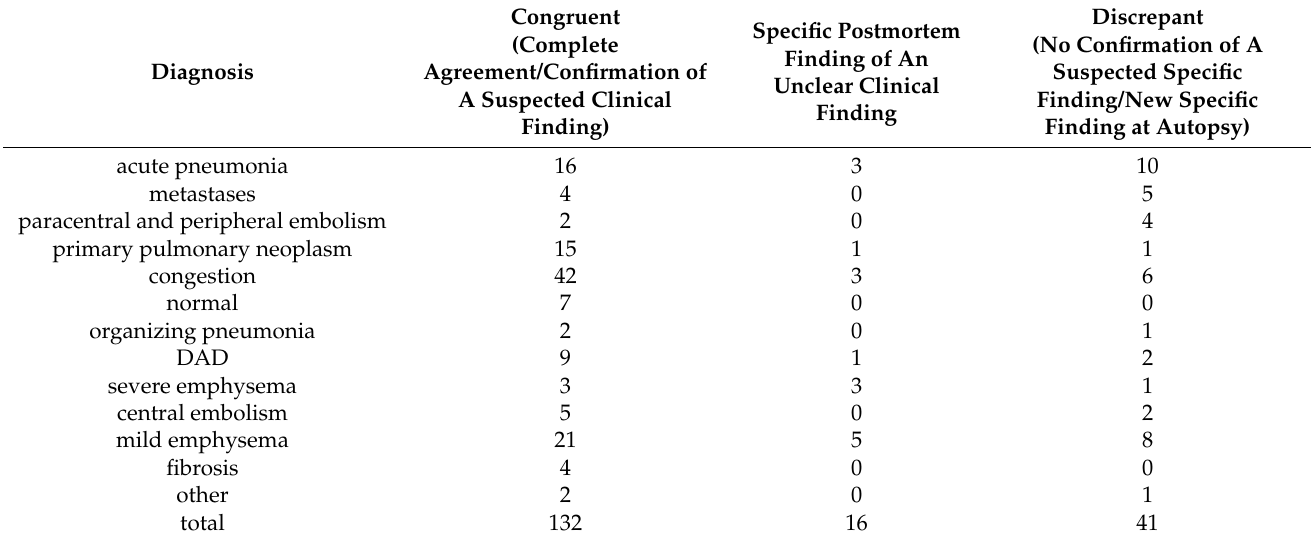
Table 2. Discrepant pulmonary diagnoses at postmortem investigation (main diagnoses